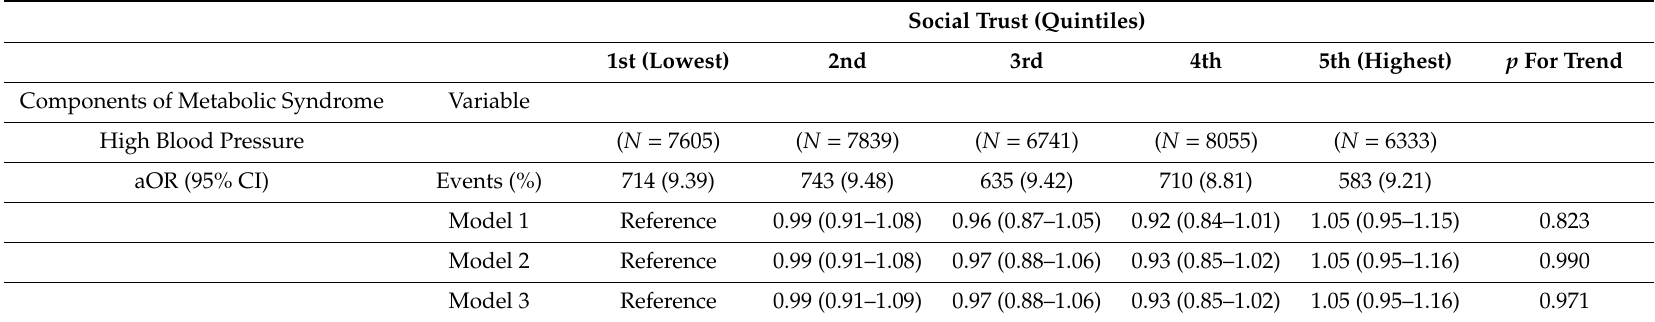
Table 3. Adjusted odds ratio of (95% confidence intervals) for each metabolic syndrome criterion by social trust